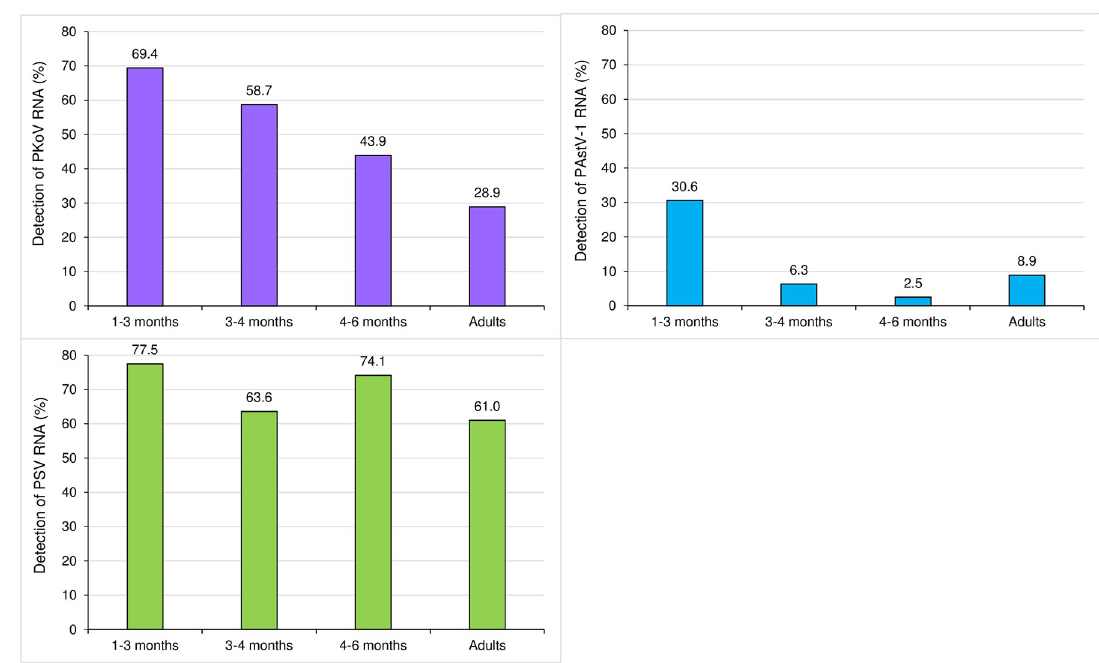
Fig 1. Detection rate of each RNA virus by age group.